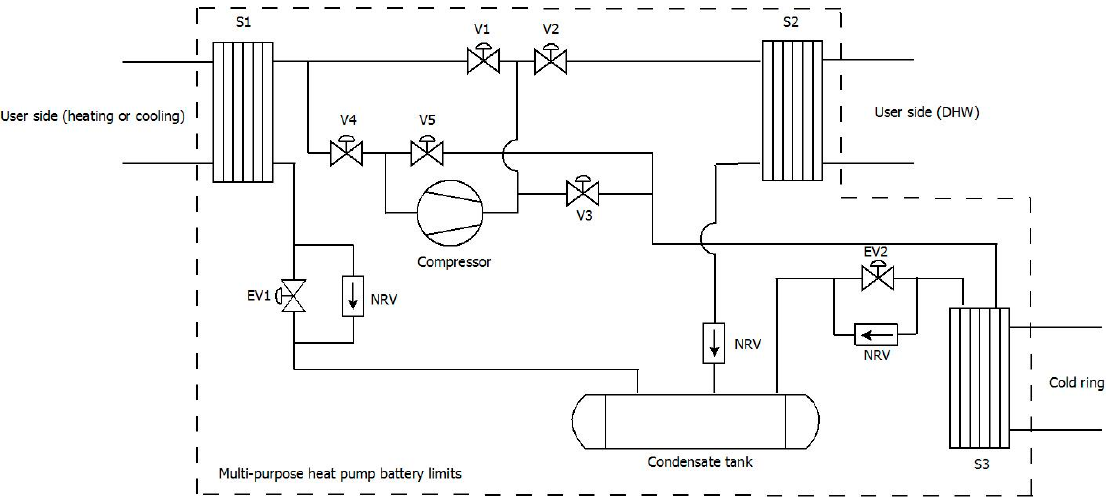
Figure 2. Piping and Instrumentation Diagram (P&ID) of a multi-purpose heat pump system: in particular, heat exchangers (S1, S2, S3), solenoid valves (V1, V2, V3, V4, V5), expansion valves (EV1, EV2) and non-return valves (NRV) are shown.